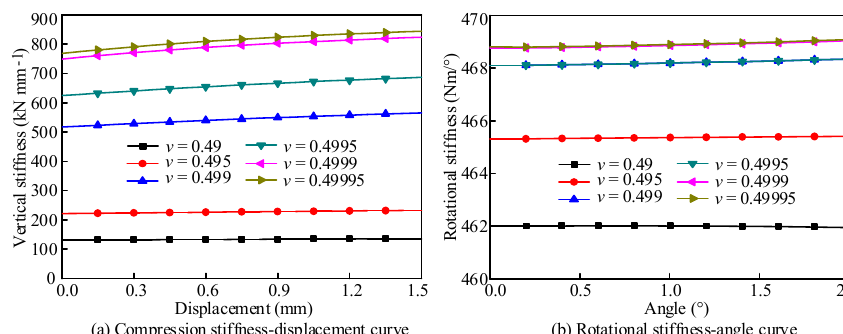
curveAngle (°) (b) Rotational stiffness-angle